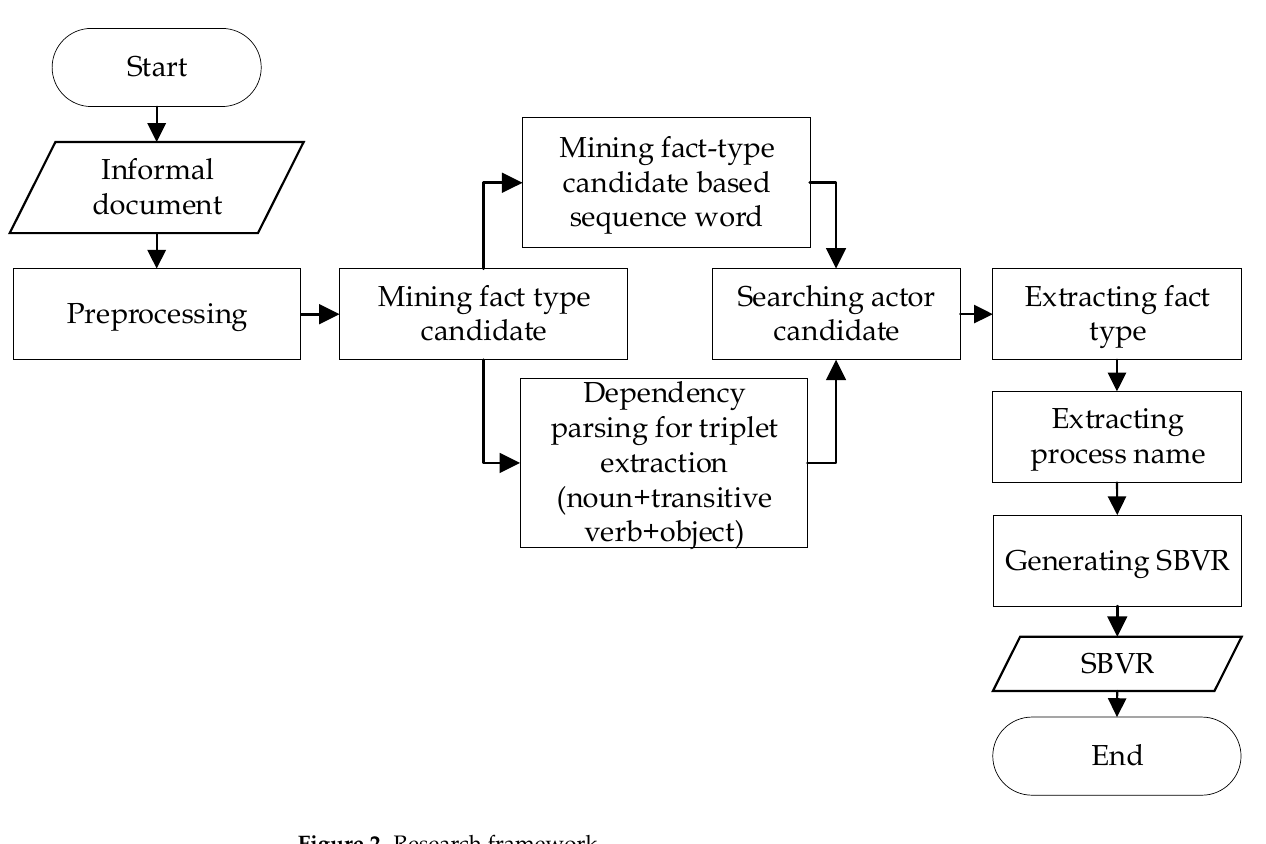
Figure 2. Research framework.